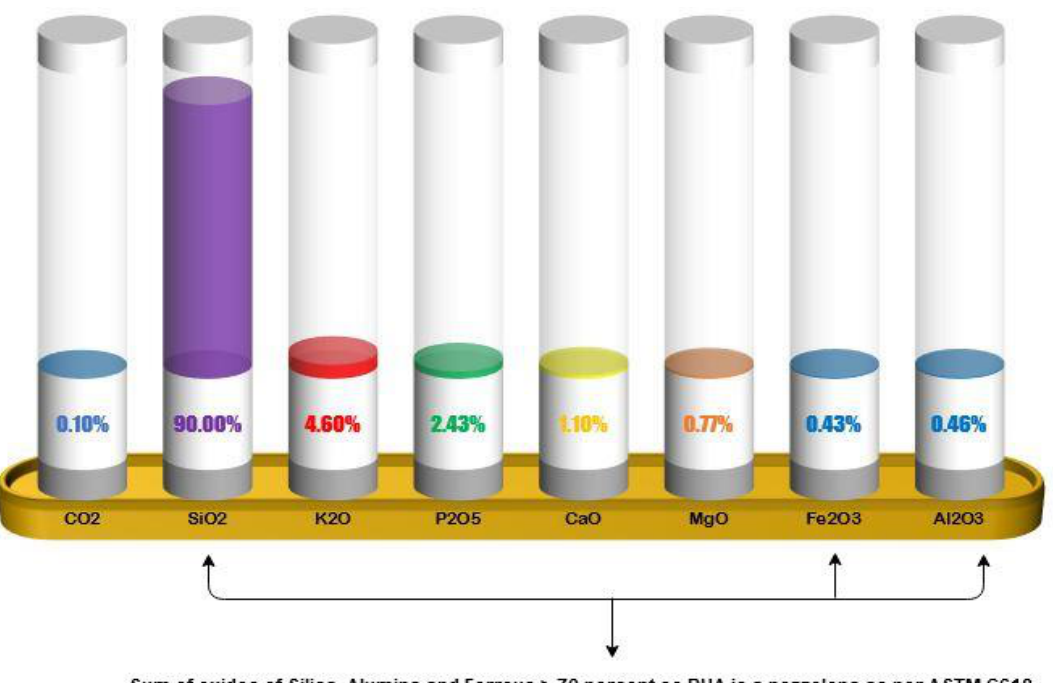
Figure 1. Chemical composition of RHA .